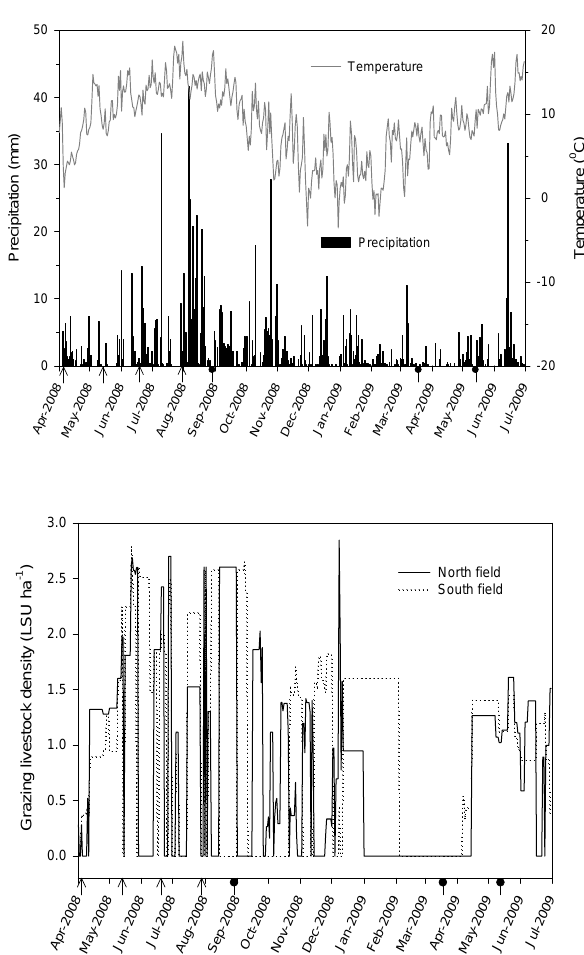
Fig. 1. Seasonal variation in temperature (grey line) and precipitation (black columns) (A), and grazing livestock density in north (solid line) and south field (dots) (B). Arrows below the X-axis represent N application as NH 4 NO 3 ; the bar with solid circle represents N application as urea. Data provided by Centre for Ecology & Hydrology, Edinburgh, Scotland.